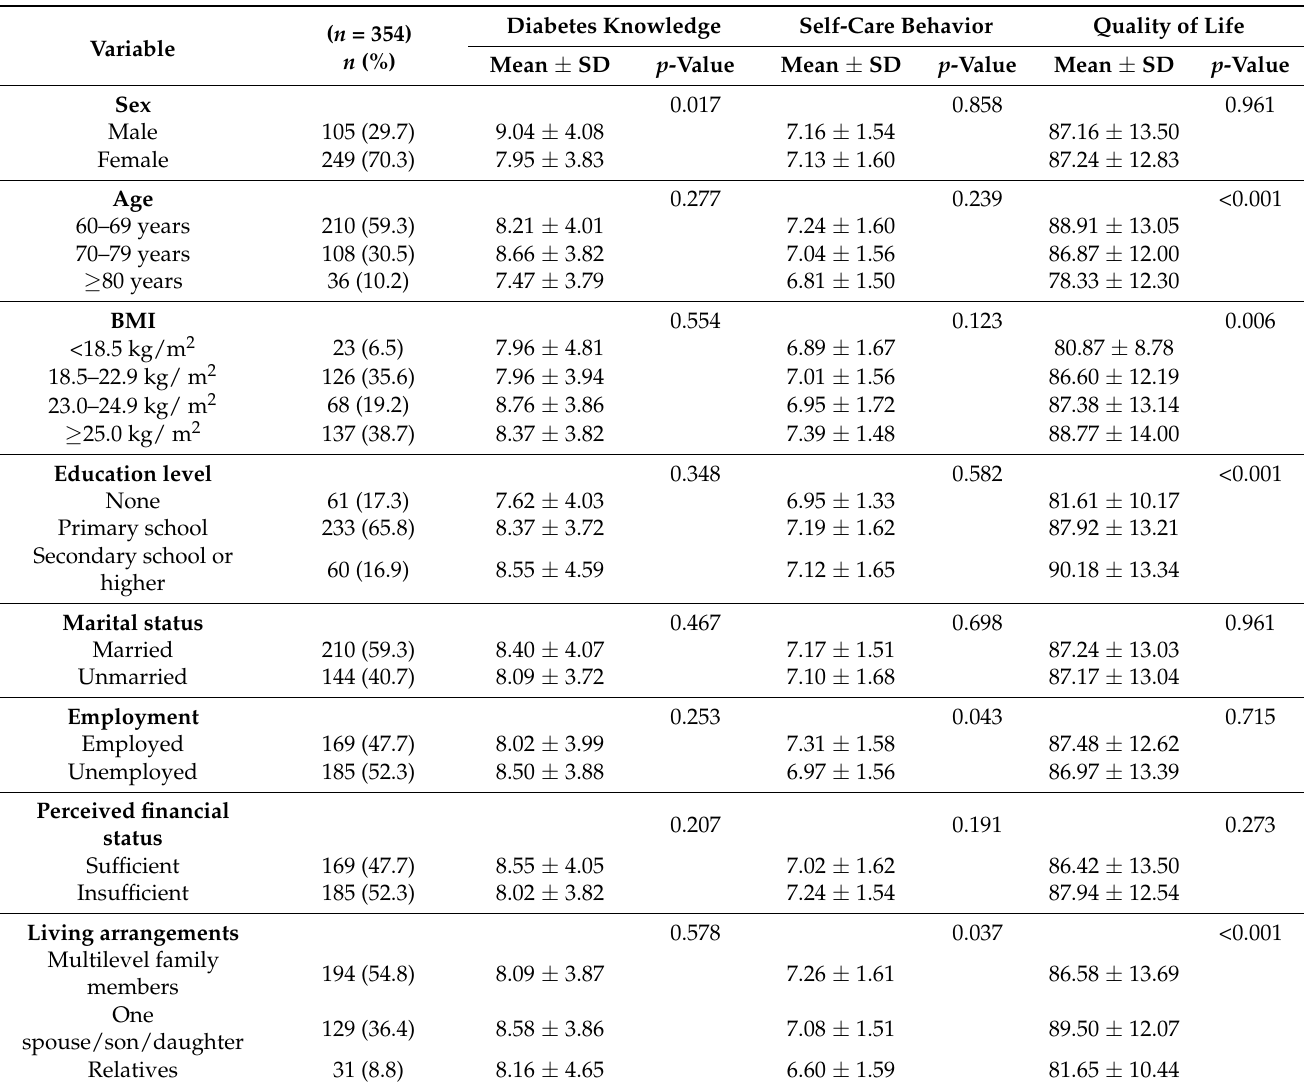
Table 1. Factors of elderly diabetic patients that related to their diabetes knowledge, self-care behavior, and QoL ( n =